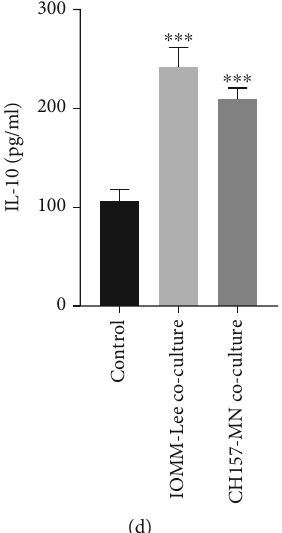
Figure 1: Macrophages are enriched in meningioma tissue, and coculture with meningioma cells promotes M2 polarization of macrophages. (a) Immunohistochemical staining was used to detect the distribution of macrophages and the expression levels of polarization markers in meningiomas and meningeal tissues. Scale bar 50 μ m. (b) Detection of mRNA expression levels of CD163, CD206, ARG1, IL-10, CD86, and TNF- α in macrophages by qPCR. (c) After coculture with tumor cells, the protein expression levels of CD163, CD206, and ARG1 in macrophages were detected by western blotting. (d) ELISA assay was used to detect the content of IL-10 secreted by macrophages in culture supernatant. ∗ p < 0 : 05 , ∗∗ p < 0 : 01 , ∗∗∗ p < 0 : 001 , vs. the control